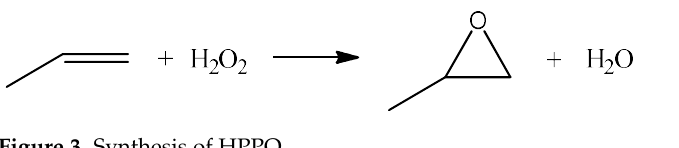
Figure 3. Synthesis of HPPO.